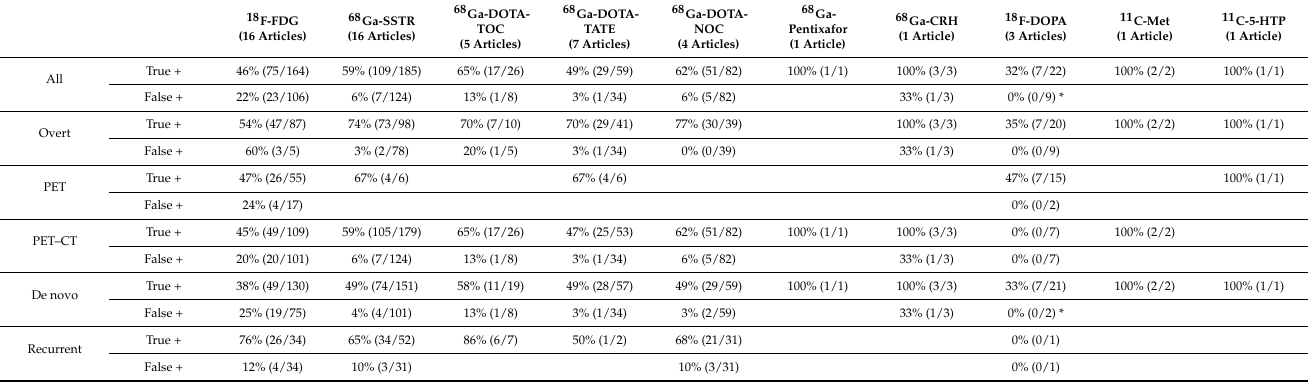
Table A2. Diagnostic accuracy of molecular imaging in ectopic Cushing’s